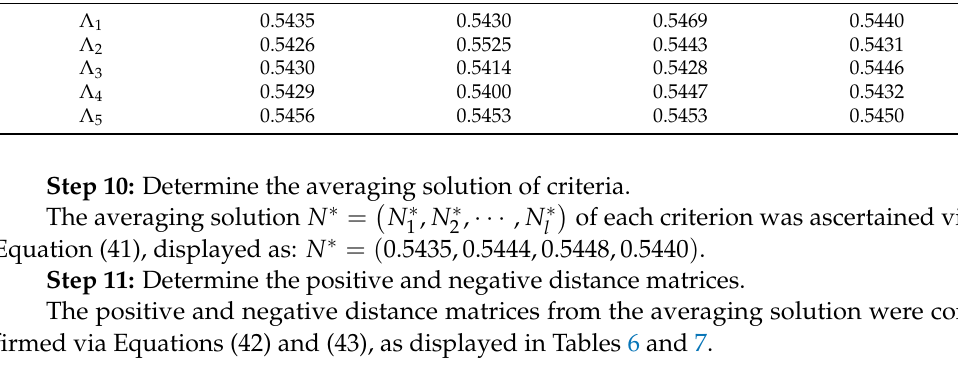
Table 5. Overall utility matrix V = ( v kl )